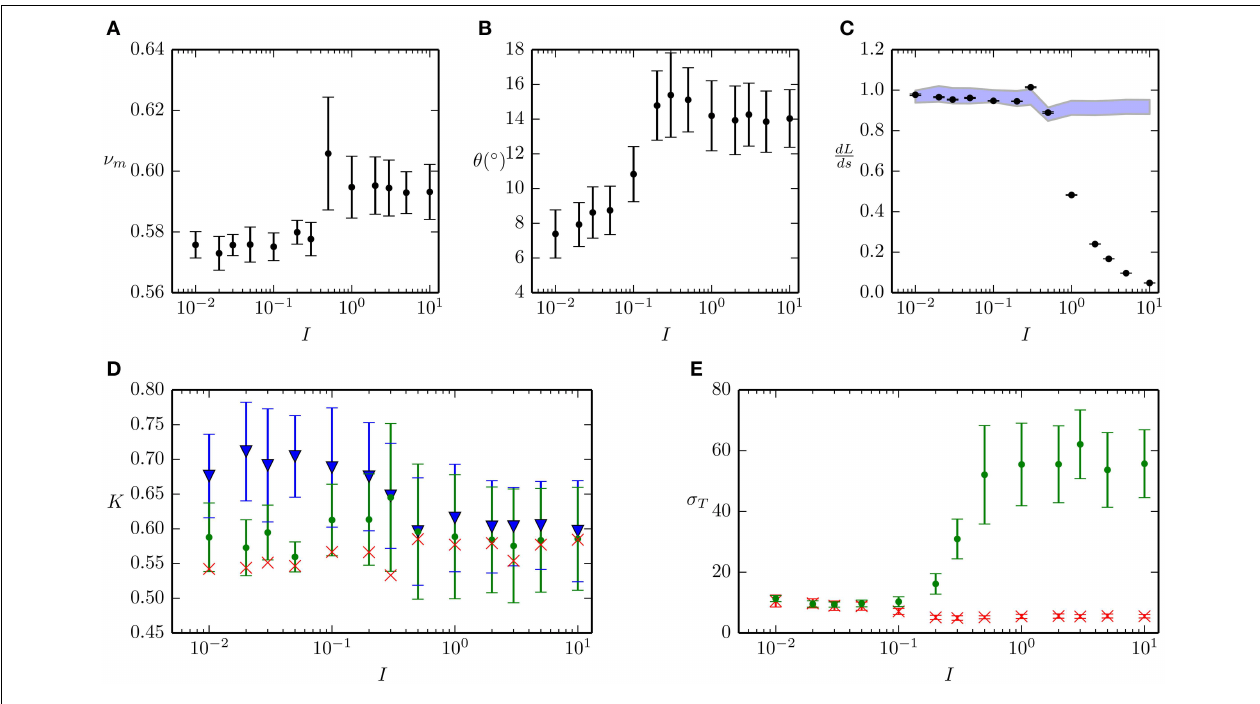
FIGURE 8 | Descriptors of the system with varying inertial number I . Error bars in each plot represent one standard deviation of the measured value. (A) Average solid fraction within the plug zone, ν m . (B) Slope of the pile in the transition zone, θ . (C) Slope of the best fit value of L ( s ) denoted by black dots against prediction using incompressibilty shown as the shaded region, which denotes ± one standard deviation around the mean value for each case. (D) Crosses